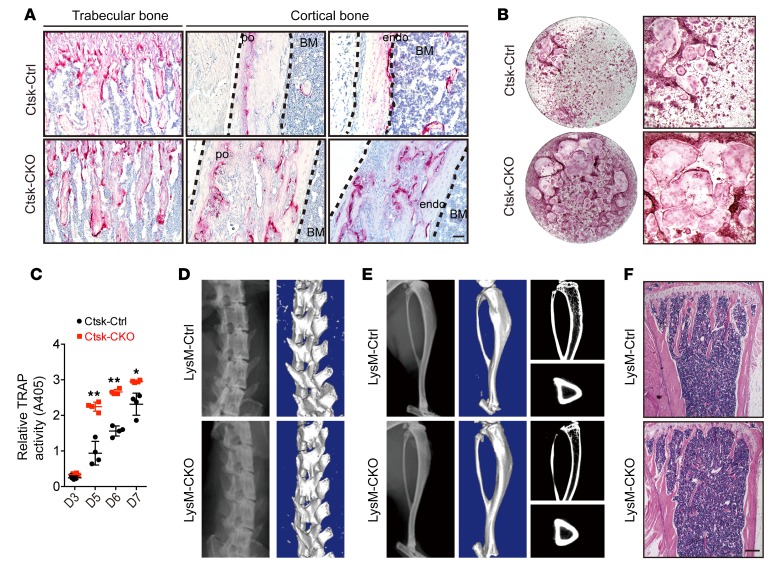
Loss of Lkb1 in osteoclast precursors does not cause osteogenic tumor–like phenotype.(A) TRAP staining of trabecular bone, periosteum (po), and endosteum (endo) of tibiae from 5-week-old Ctsk-Ctrl and Ctsk-CKO mice. Scale bar: 100 μm. (B and C) TRAP staining (B) and quantification of TRAP activity (C) of cells differentiated from Ctsk-Ctrl and Ctsk-CKO BM cells in the presence of M-CSF and RANKL. (D–F) Phenotypic analysis of 20-week-old LysM-Ctrl and LysM-CKO mice did not show osteogenic tumor formation. Representative x-ray images (D) and μCT (E) scans of the spines and tibiae and H&E staining of the tibiae (F) of 20-week-old LysM-Ctrl and LysM-CKO mice. Scale bars: 300 μm. Similar results were obtained from analyses of both male and female mice for each genotype. Data are represented as mean ± SEM. *P < 0.05; **P < 0.01, unpaired Student’s t test.